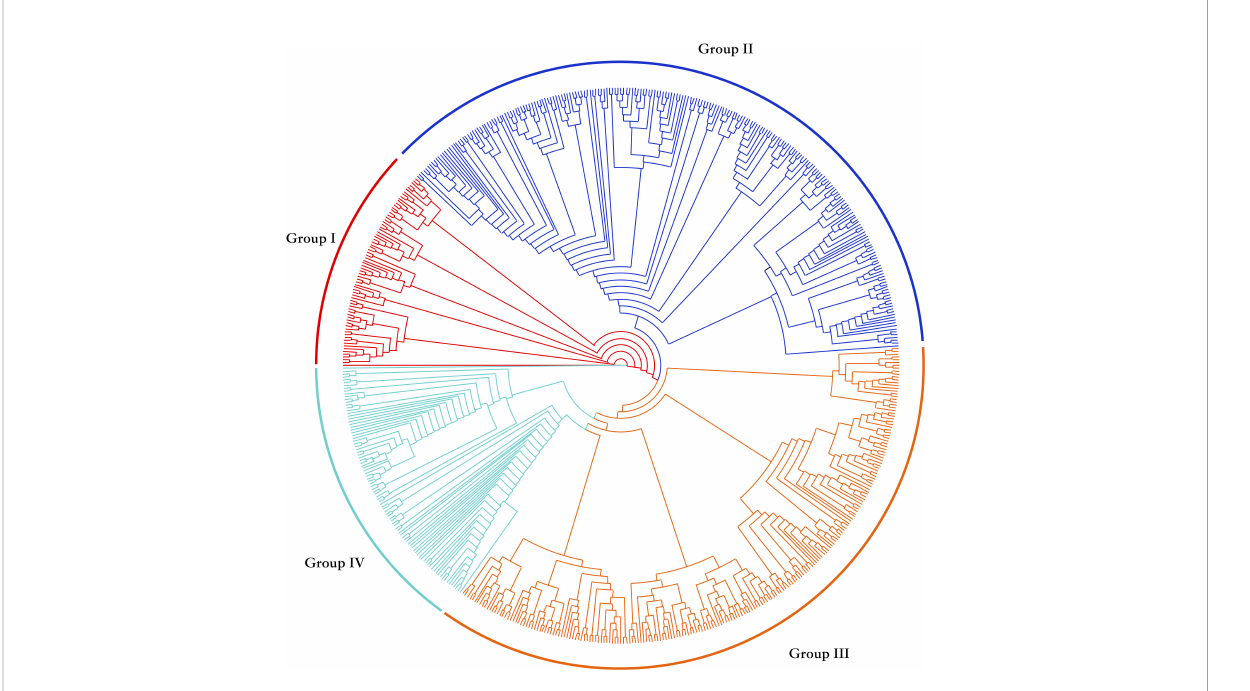
FIGURE 1 Cluster analysis of population relationship among 612